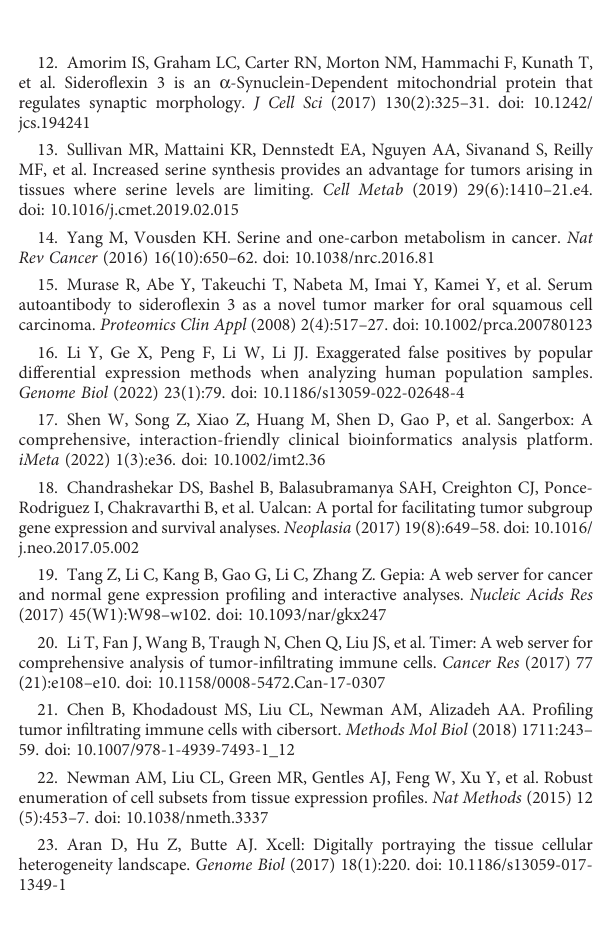
SUPPLEMENTARY TABLE 1 The expression of SFNX3 and IC50 values of common drugs in different HNSC cell lines.